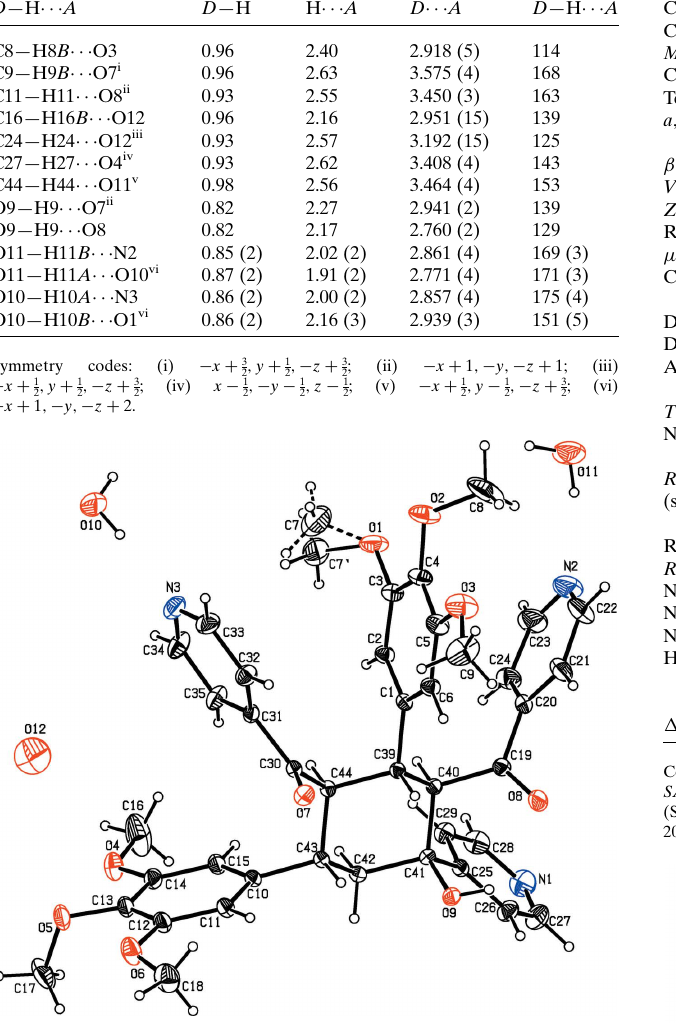
Figure 1 An ORTEP plot of the title compound with displacement ellipsoids drawn at the 20% probability level.